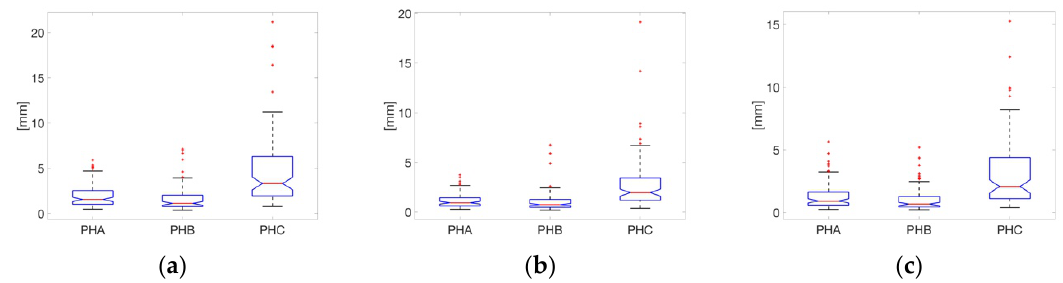
Figure 7. Mean distance distributions for each of the three phases PHA, PHB and PHC: ( a ) MD distributions, ( b ) MDX distributions and ( c ) MDY distributions.